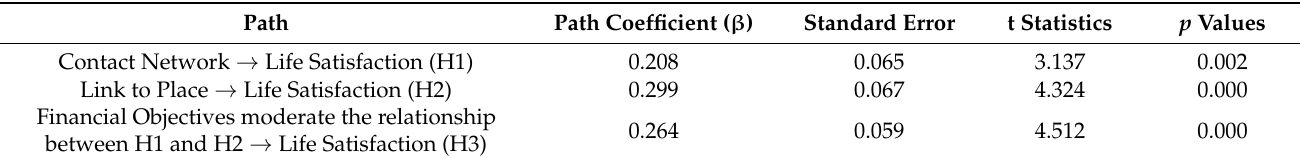
Table 2. Structural Model Assessment.